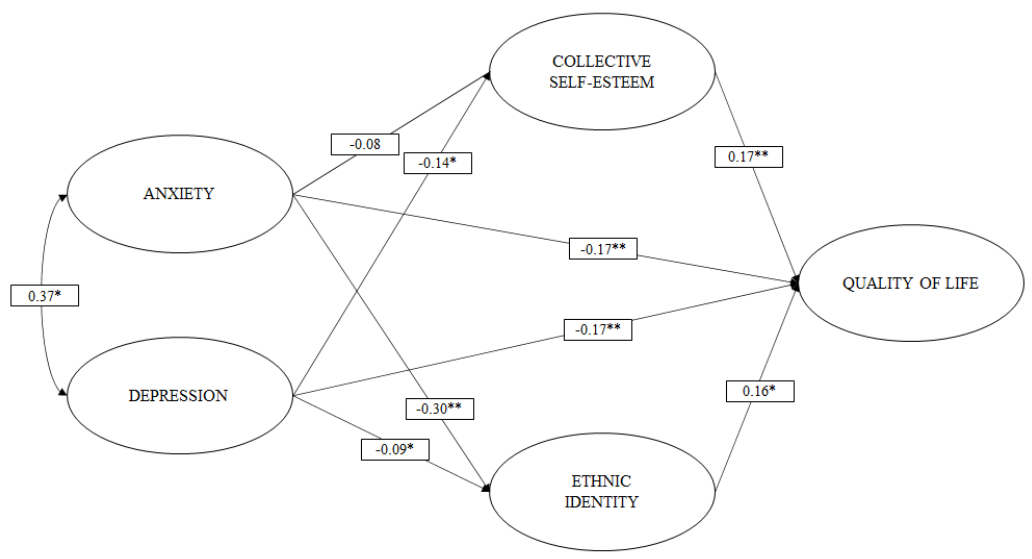
Figure 3. M9 structural model of mediation. * p < 0.05; ** p < 0.001. Table 2. Indicators of overall fit of the estimated structural